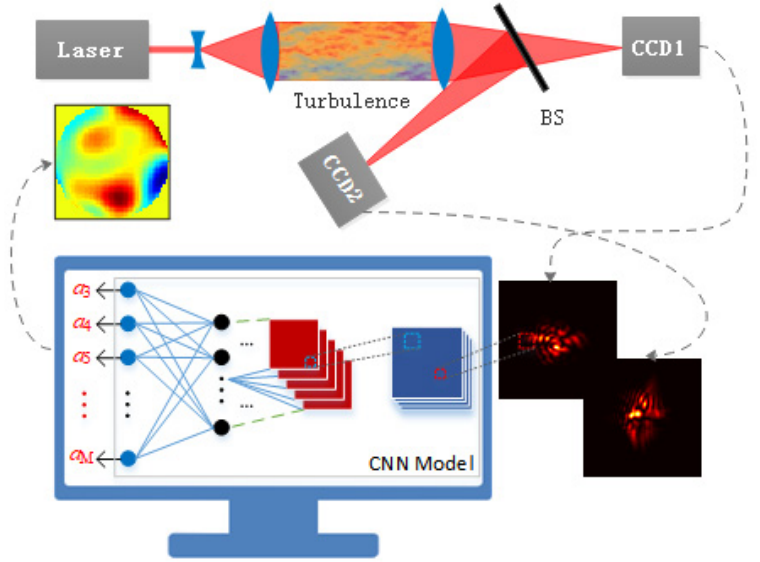
Figure 1. The diagram for turbulence aberration restoration model based on CNN.